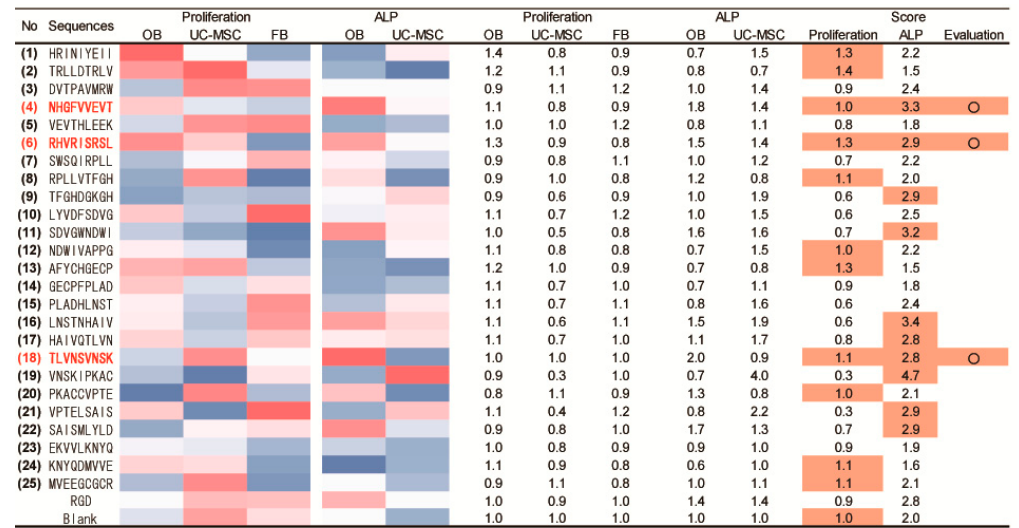
Figure 6. Screening results for osteogenic-enhancing peptides. The heat map indicates the values of cell proliferation and ALP activity. Red denotes a higher value of proliferation or ALP activity, whereas blue indicates a lower value. Score indicates the reference value denoting the osteogenic-enhancing peptides. The value of the proliferation score was calculated to subtract the FB from the sum of the OB and UC-MSC values (ex. No. 1 HRINIYEII peptide: 1.4 + 0.8 − 0.9 = 1.3). The value of the ALP score was calculated as the sum of the OB and UC-MSC values (ex. No. 1 HRINIYEII peptide: 0.7 + 1.5 = 2.2). The orange color indicates a higher value than that of the RGD peptide.